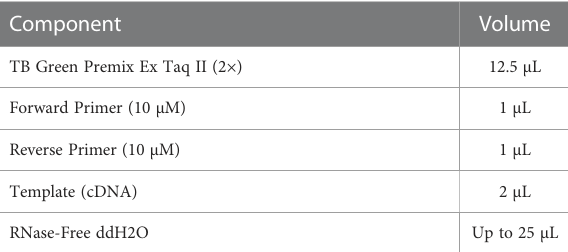
TABLE 3 RT-qPCR reaction system (25 µL).